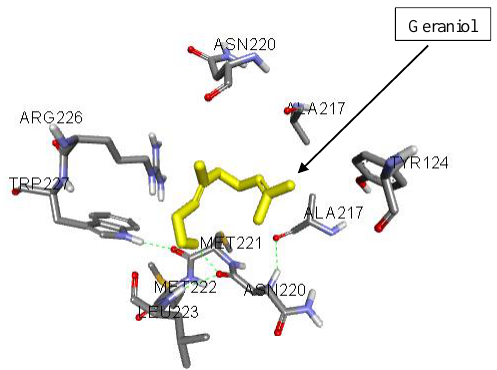
Figure 2. 3D interaction diagram of geraniol in the active cavity of HSV-2 protease.